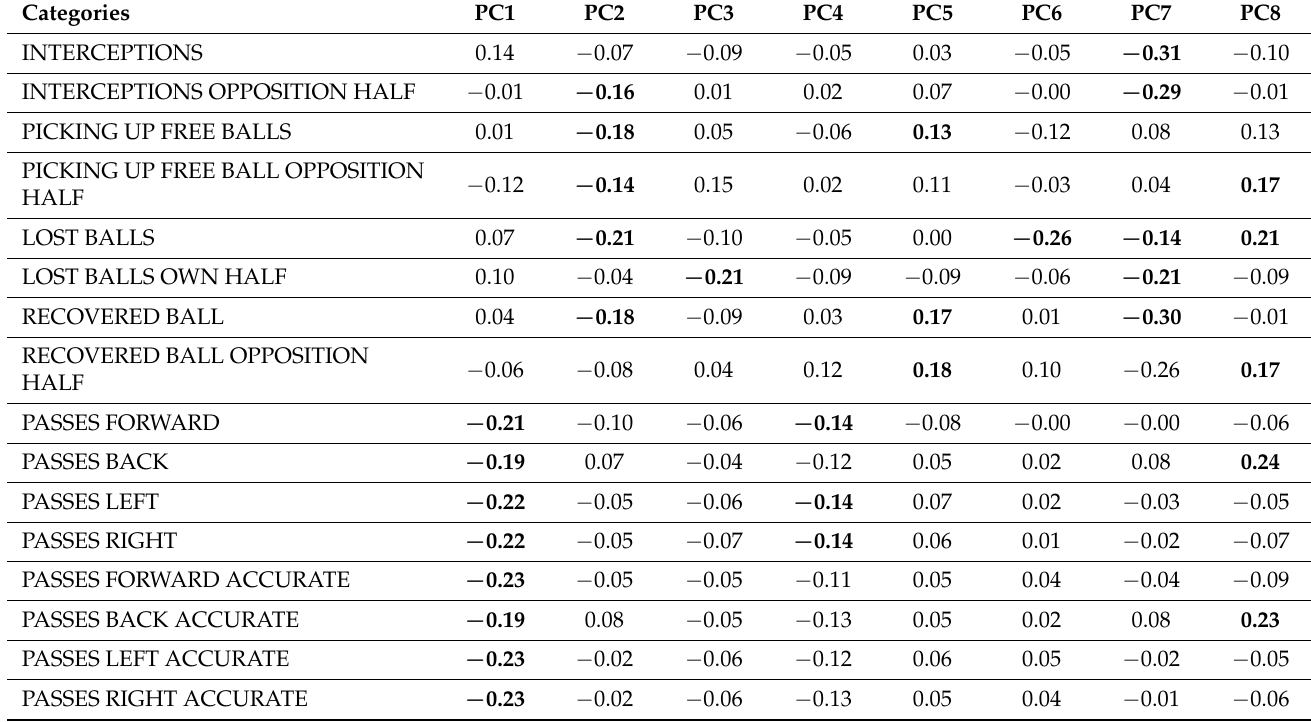
Figure 1. Screeplot of best teams. The information in this table can be summarized as shown in Figure 2. The dashed horizontal line indicates the average contribution value of the different categories in each component. A category with a value greater than this limit is considered important for that component. The dominant category (or categories) in each component was used to